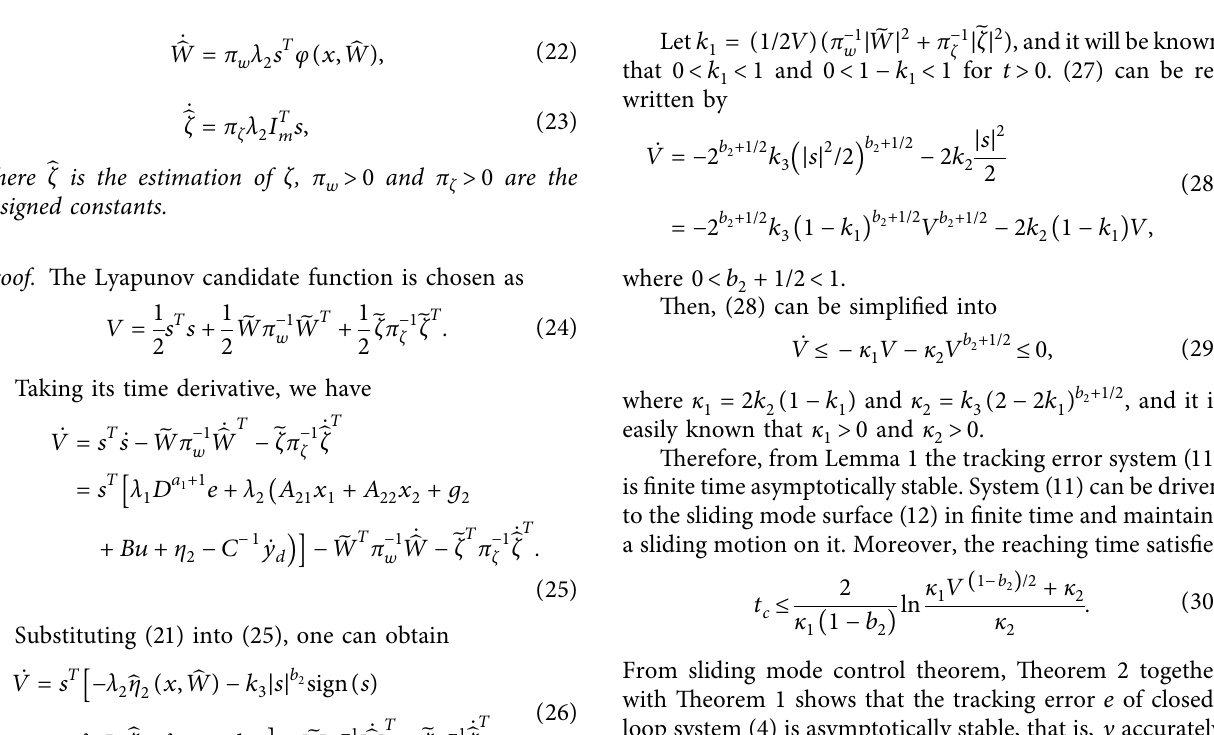
Figure 4: NN-FFOSM control scheme for epilepsy seizure